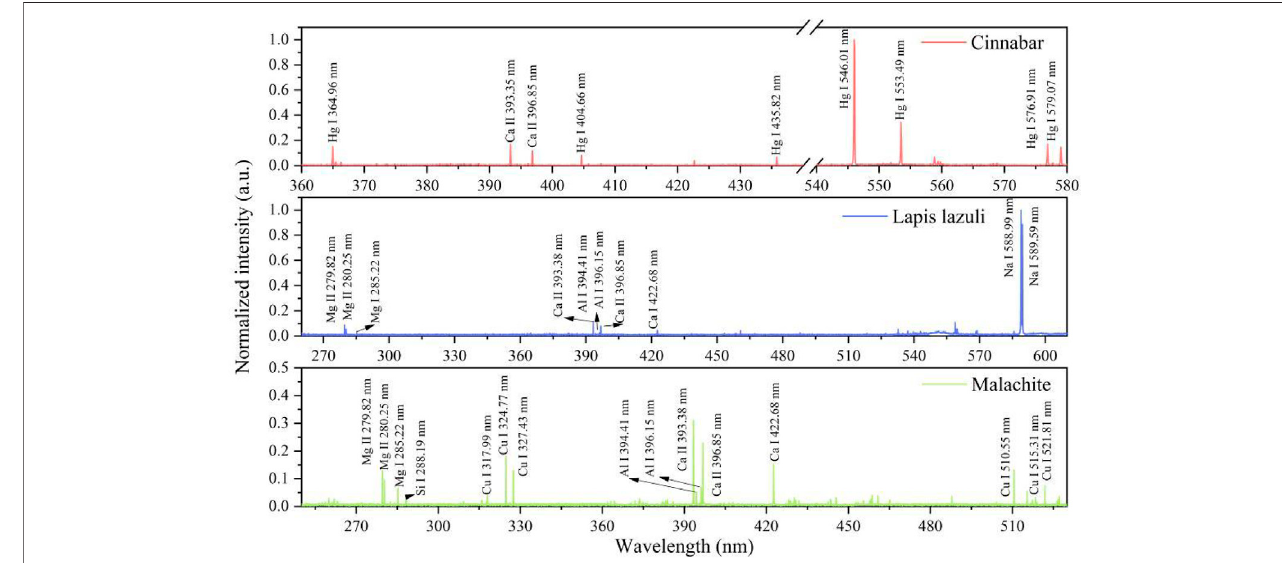
FIGURE 5 | Stable LIBS spectra of cinnabar, lapis lazuli, and malachite pigments.